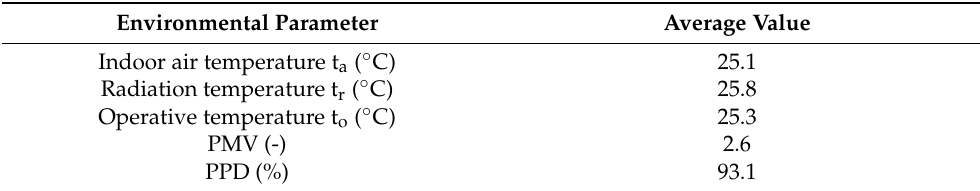
Table 3. Summary of average results of thermal microclimate and thermal comfort measurements in the hall during the period of high outdoor air